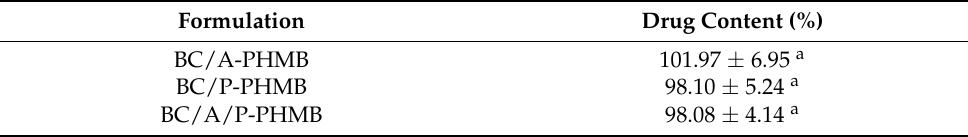
Table 4. Drug content of BC/A-PHMB, BC/P-PHMB and BC/A/P-PHMB